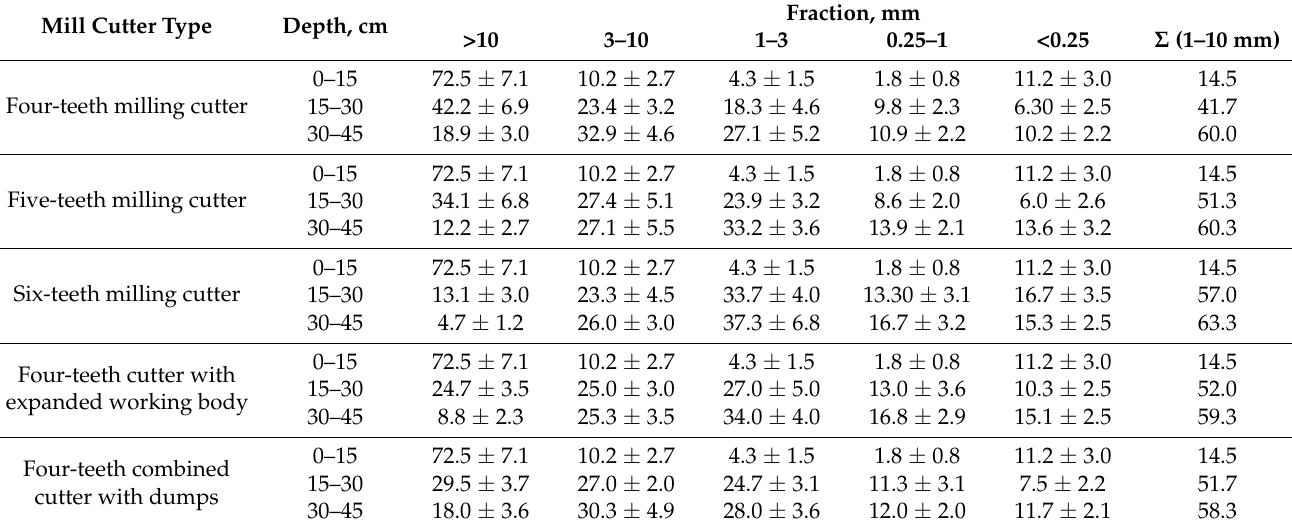
Table 2. Soil crumbling depending on the milling cutter type, % (dry